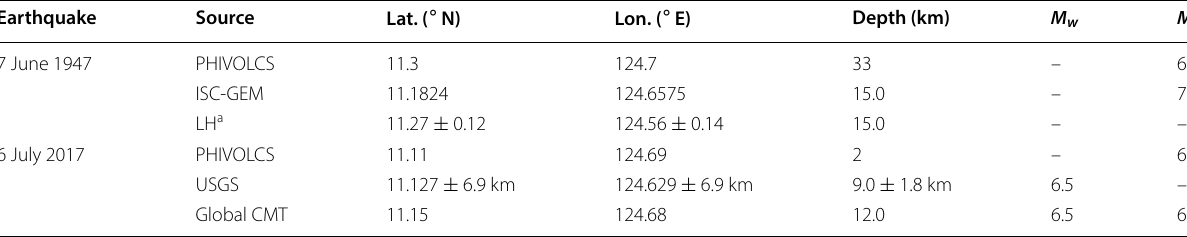
a Lumbang and Hurukawa (2014)